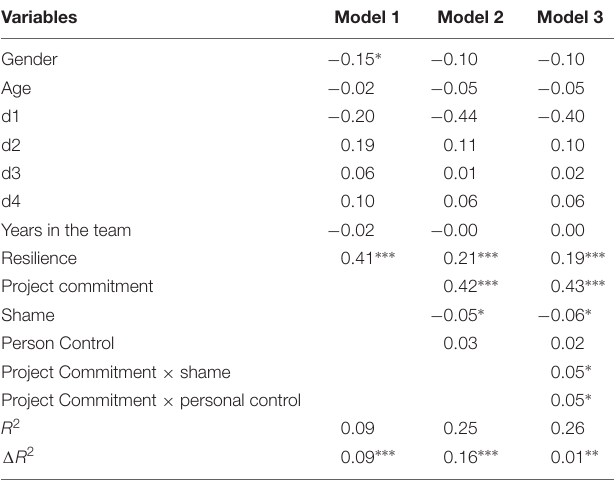
TABLE 3 | Single-level estimates for models.